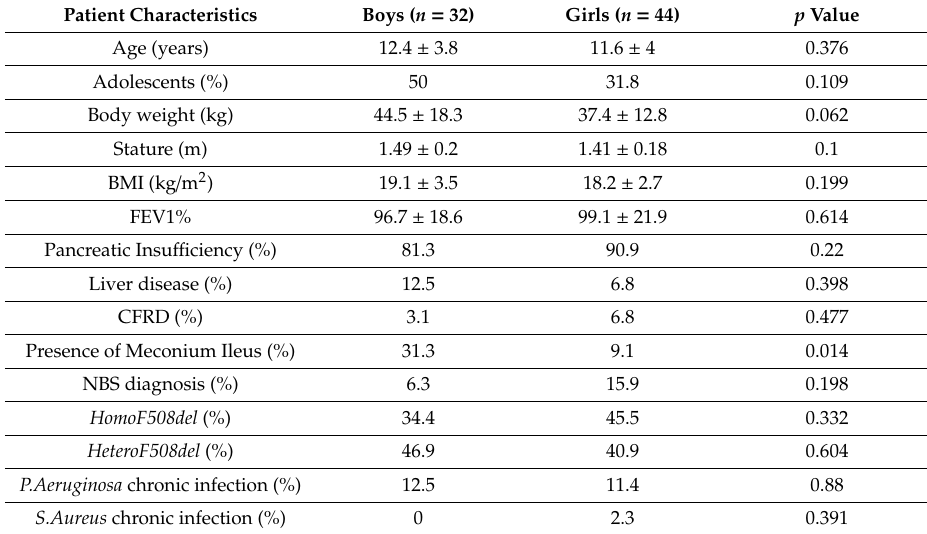
Table 1. Sample characteristics ( n =